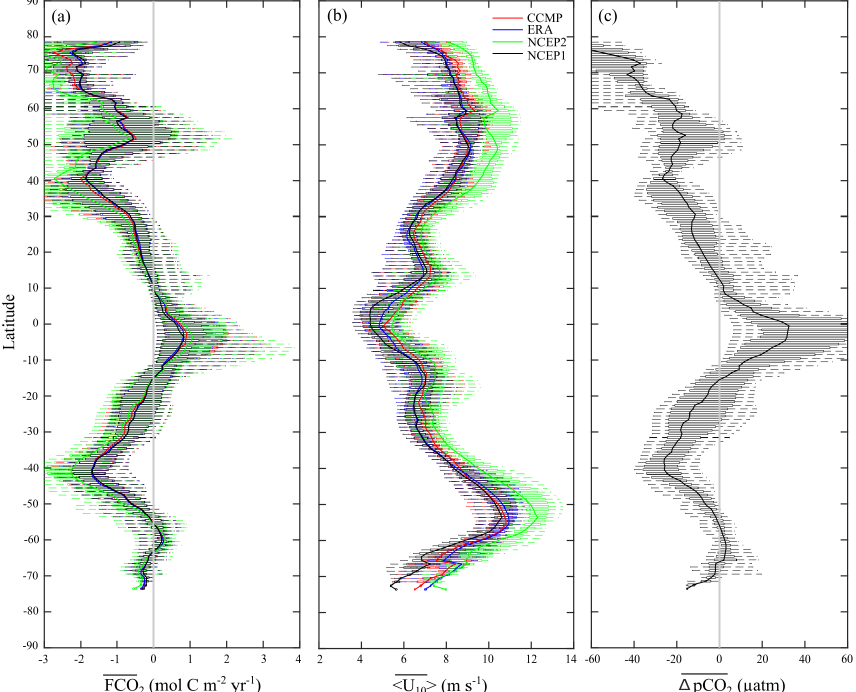
Figure 2. Latitudinal distribution of F CO 2 (molCm − 2 yr − 1 ) (a) , U 10 (ms − 1 ) (b) and (cid:49)p CO 2 (µatm) (c) using the CCMP, ERA, NCEP1 and NCEP2 wind products. F CO 2 is calculated using the quadratic k − U 10 relationship from Wanninkhof (2014). Results refer to the 1991– 2011 period. The median value for each latitude is represented by a line, while the box plots delineate the 5th and 95th percentile of the variation within each 1 ◦ latitudinal band,